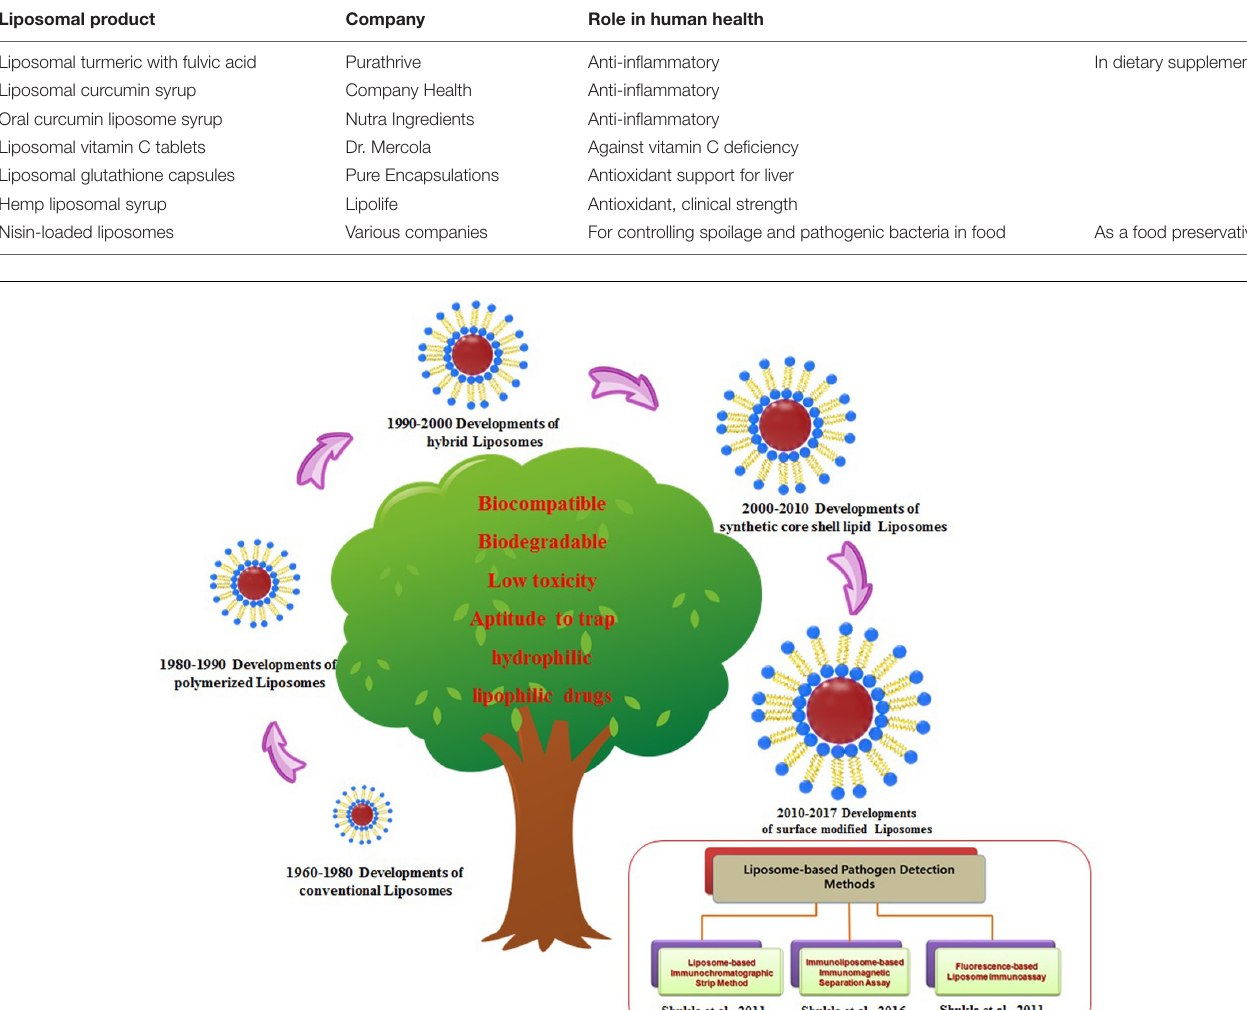
TABLE 1 | Approved selected liposome-based commercial products.